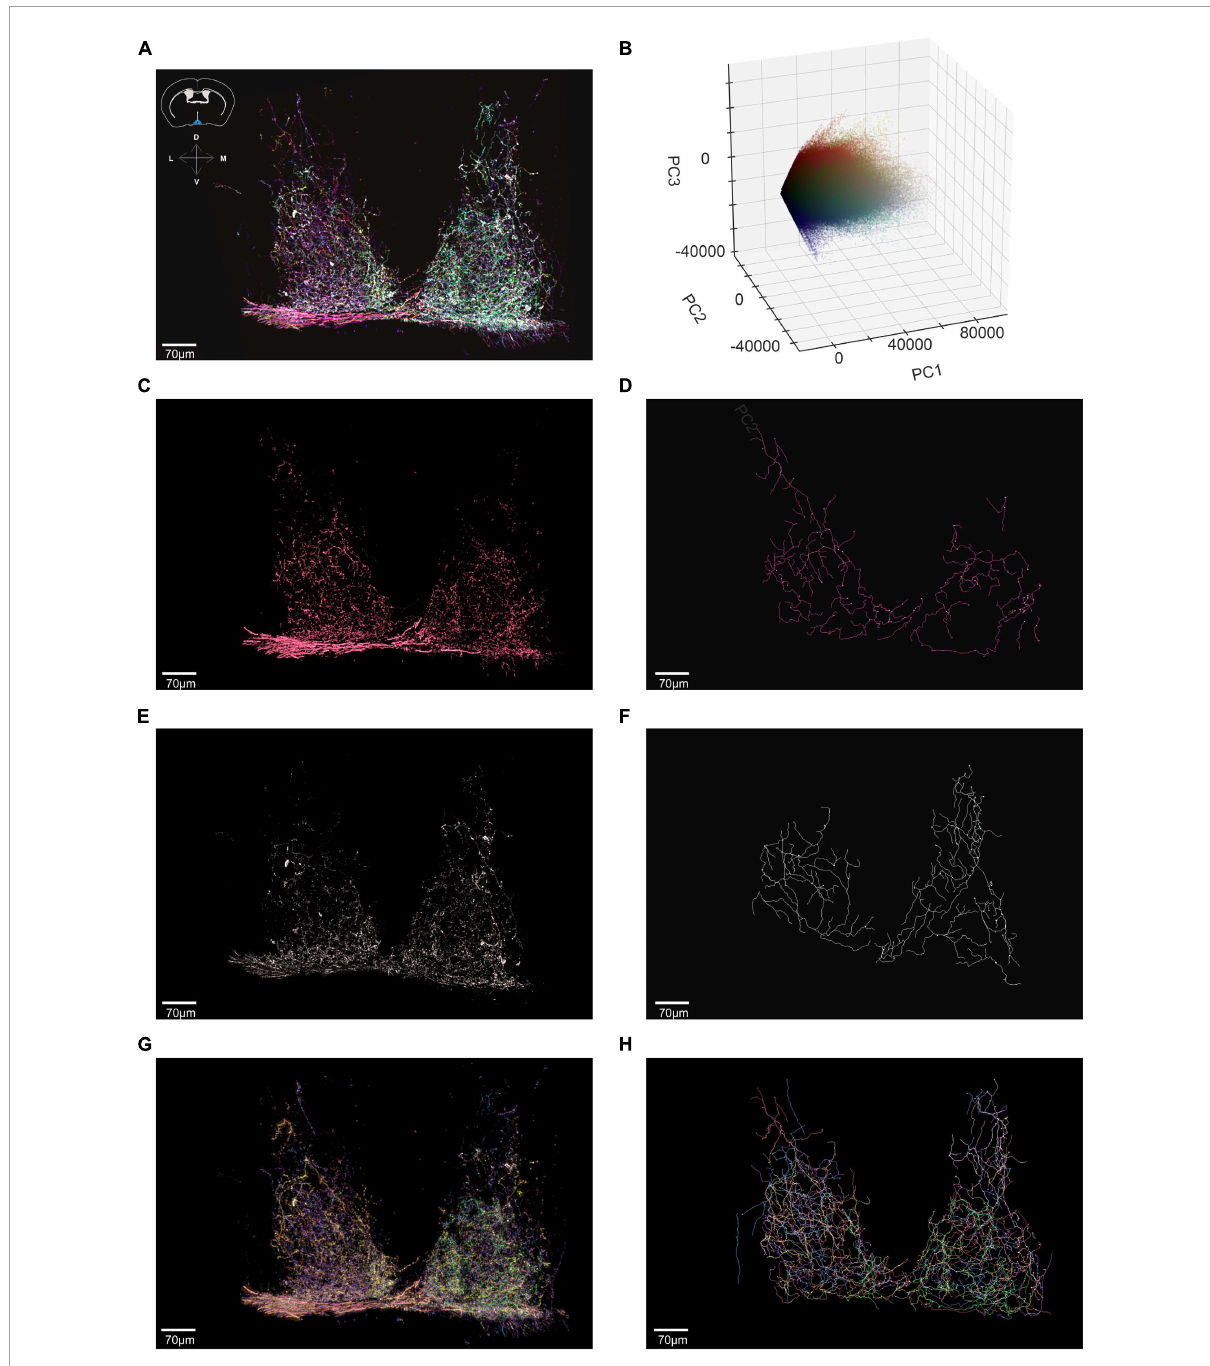
FIGURE7 Using BRIAN to trace axonal projections of ipRGCs in the Suprachiasmatic Nucleus (SCN). (A) Confocal tile-scanned image of a representative of a 60 µ m thick coronal section of the Opn4 Cre / + ;rd/rd SCN (Suprachiasmatic Nucleus), following a unilateral intravitreal AAV Brainbow injection and immunohistochemical staining for the mCherry (pseudocolored red), eYFP (pseudocolored green) and mTFP (pseudocolored blue) reporter proteins following pre-filtering. Inset: schematic diagram of a coronal cross-section from the mouse atlas (above) illustrates anatomical position of the SCN in blue. (B) 3D representation of the PC space (PC1 vs. PC2 vs. PC3) for the filtered ROI shown in panel (A) which depicts all voxels in the filtered image. (C) Spatial reconstruction of voxels from the isolated red cluster in an en face view. (D) Filament tracer reconstructions in an en face view of the red cluster isolated using the BRIAN platform revealed 3 continuous filaments (which may represent the axonal projections of 3 cells with similar color or parts of the same neuron that would be continuous if viewed in a larger brain volume). (E) Spatial reconstruction of voxels from the isolated white cluster in an en face view. (F) Filament tracer reconstructions in an en face view of the white cluster isolated using the BRIAN platform. (G) Spatial location of voxels in en face view from 7 separate clusters (color of each voxel matches that of its appearance in the pseudocolored representation of this ROI in A ) isolated from the PCA (B) . (H) Filament tracer image of the seven voxel clusters in panel (G) in en face projection (Franklin and Paxinos,